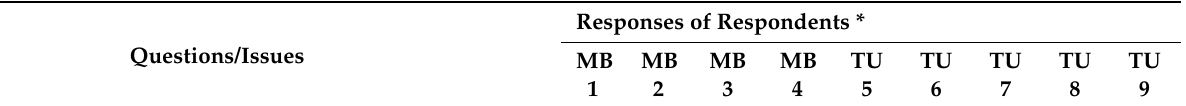
Table 1. Assessment of corporate social responsibility strategy at the level of PGE and the Opole Power